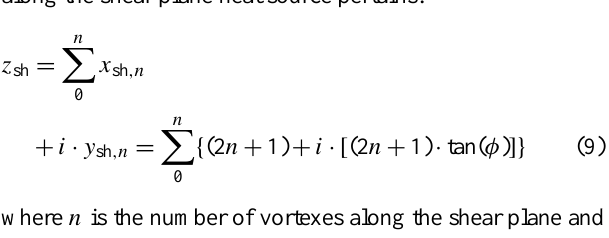
Figure 4. Comparison of model plot and infrared image (for In- conel 718, HSS tool, cutting depth 30µm).